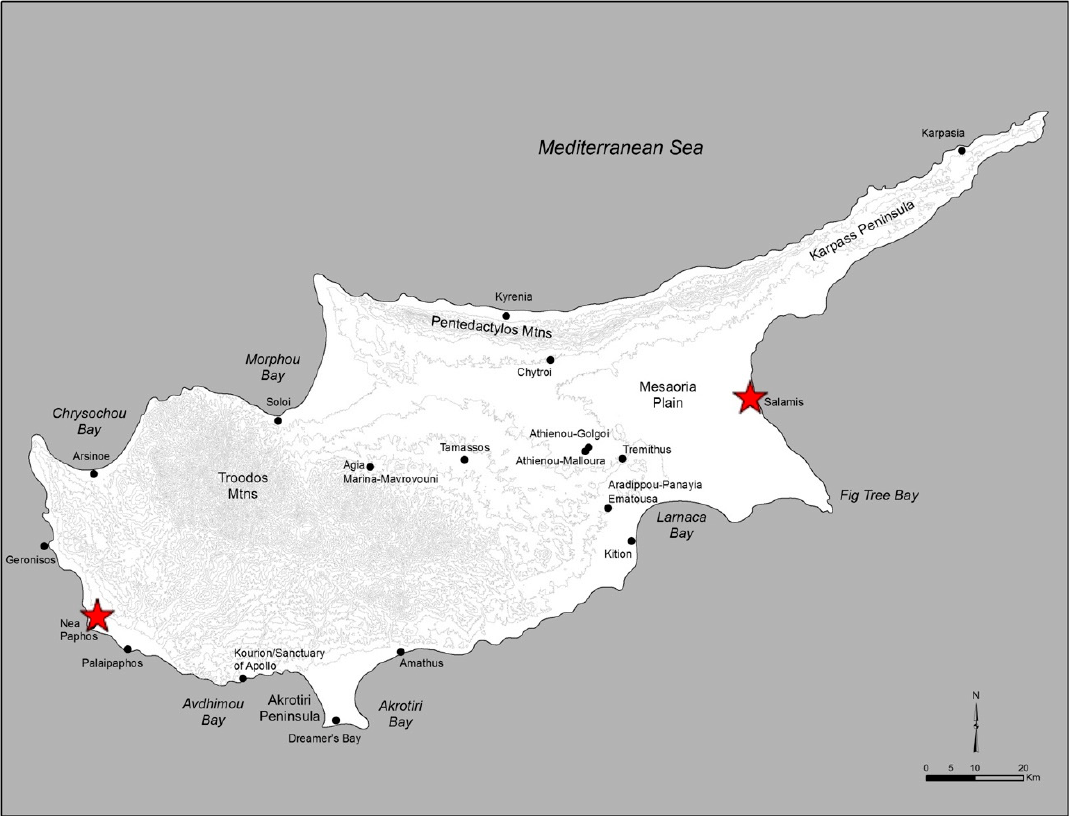
Figure 2. Map of Cyprus showing significant Early Roman period sites. Note Nea Paphos on the west coast and Salamis on the east coast (marked by red stars). Map courtesy of Brandon Olson.